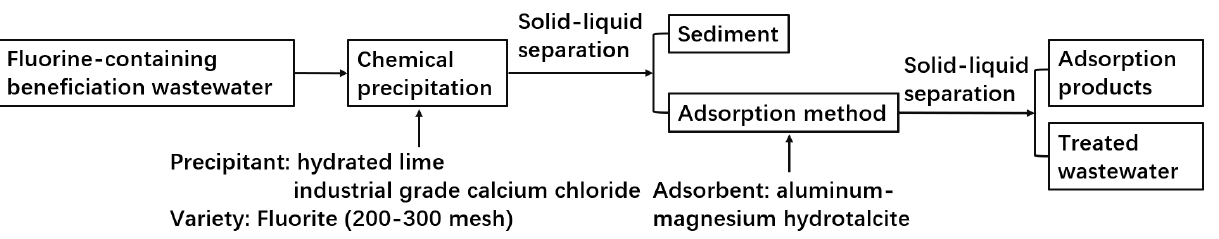
Figure 4. Flow chart of chemical precipitation – adsorption process.